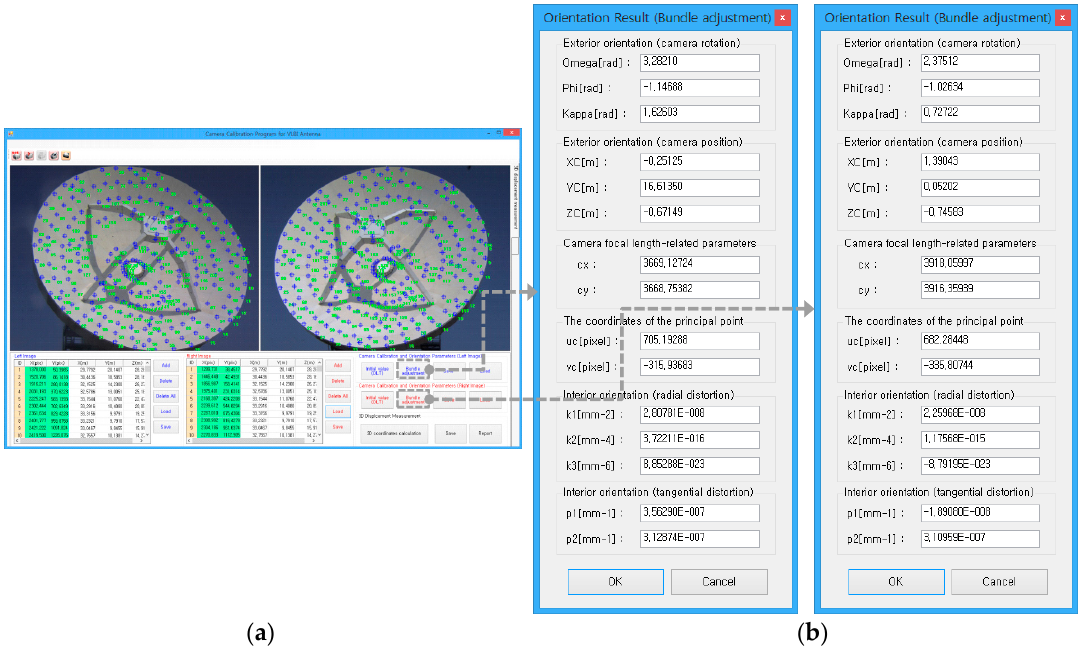
Figure 11. Result screen for the initially calculated interior and exterior orientation parameters for the stereo images. ( a ) the final orientation results for the left image; ( b ) the final orientation results for the right image.